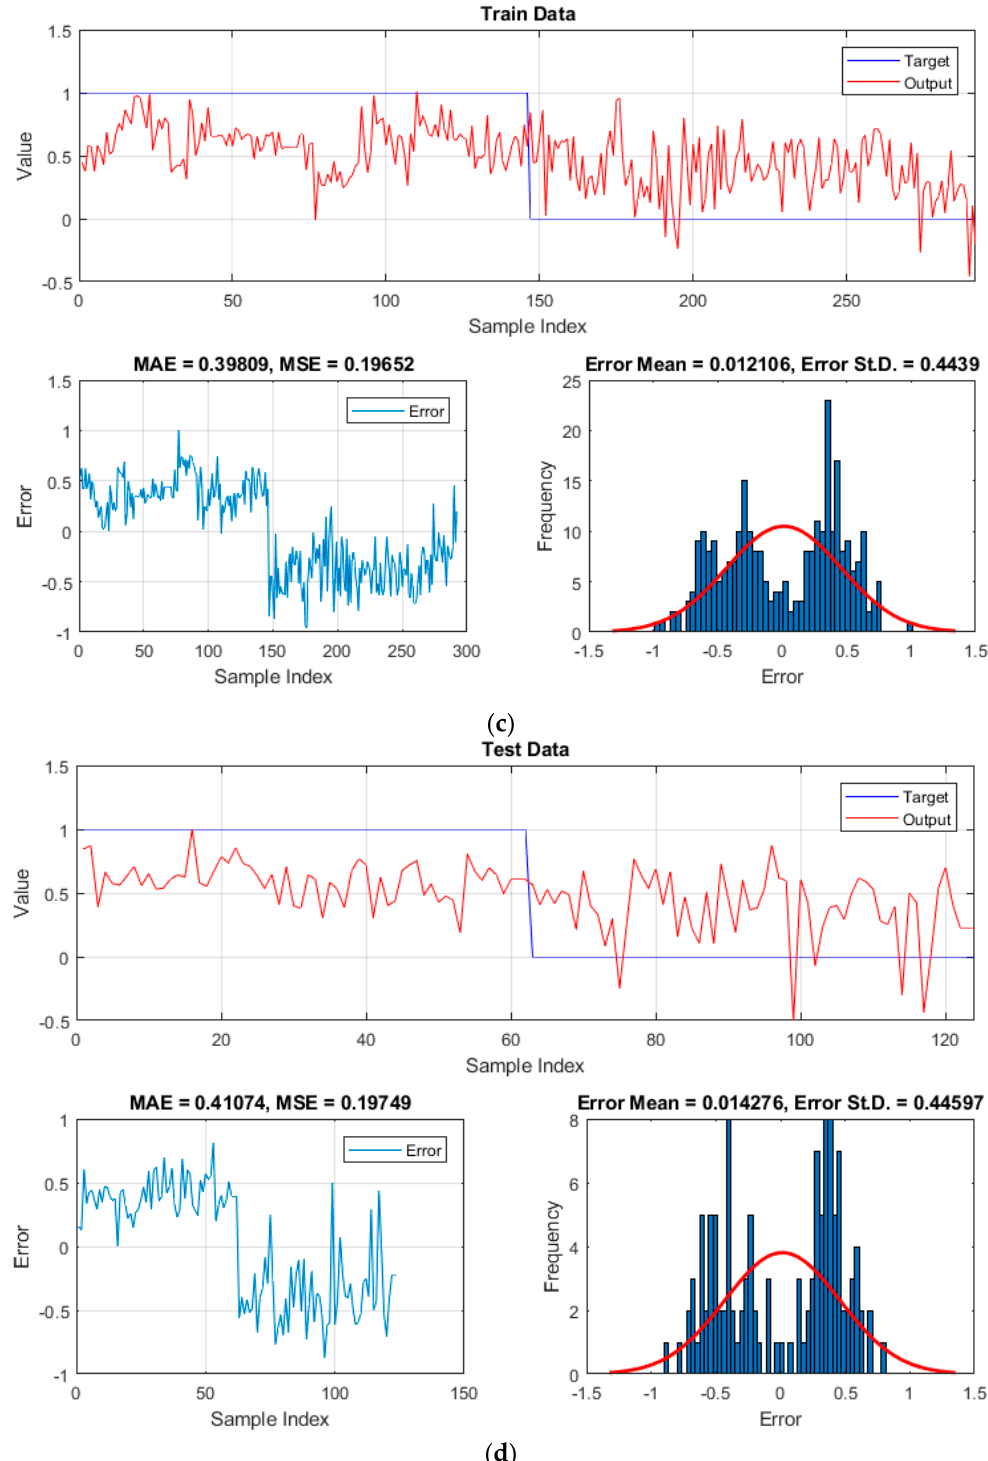
Figure 8. The results obtained for the ( a and b ) ANN and ( c and d ) HHO–ANN for the training and testing samples, respectively. samples,